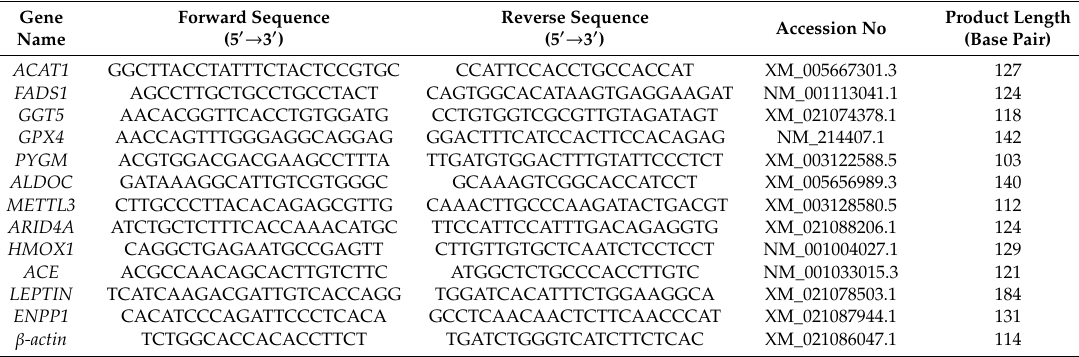
Table 3. Details of the